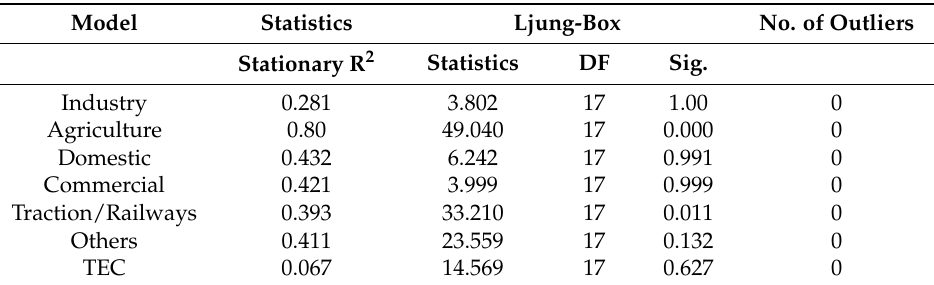
Table 9. Summary of Brown model.